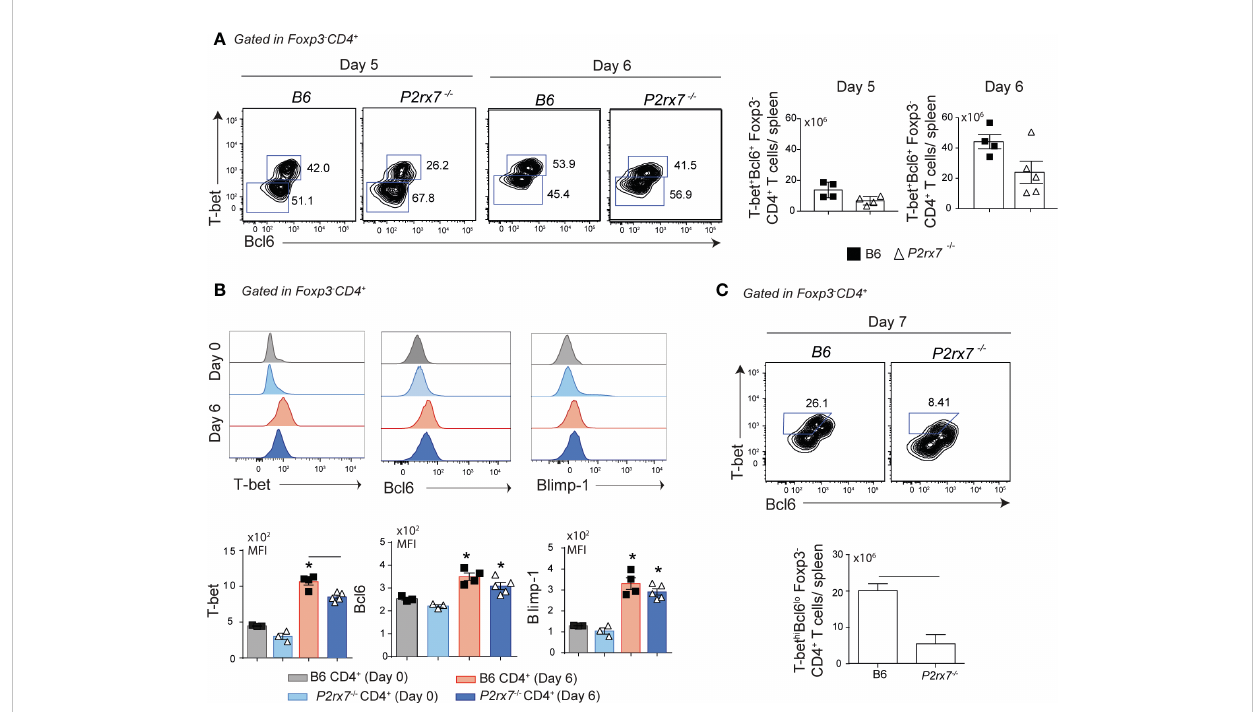
FIGURE 1 Early effects of P2RX7 on T-bet expression by splenic CD4 + T cells that respond to Plasmodium infection. B6 and P2rx7 -/- mice were infected i.p. with 1 x 10 6 iRBCs. (A) Contours plots show T-bet and Bcl6 expression in Foxp3 - CD4 + T cells at days 5 and 6 of infection. Column bar graphs show T-bet + Bcl6 + Foxp3 - CD4 + T cell numbers per spleen. (B) Histograms show T-bet, Bcl6 and Blimp-1 expression in Foxp3 - CD4 + T cells at day 6 of infection. Column bar graphs show median fl uorescence intensities (MFIs) for T-bet, Bcl6 and Blimp-1. (C) Contours plots show T-bet and Bcl6 expression in Foxp3 - CD4 + T cells at day 7 of infection. Column bar graph shows T-bet hi Bcl6 lo Foxp3 - CD4 + T cell numbers per spleen. Data are shown as the mean ± SD (n = 4-5) of one representative experiment out of three. Signi fi cant differences are observed for the (-) indicated